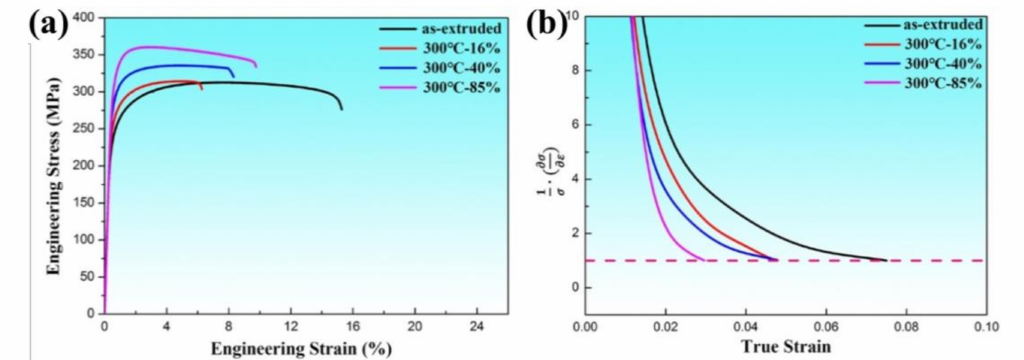
Figure 6. ( a ) Engineering tensile stress and strain curves of AlN / Al nanocomposites with various rolling reductions at 300 ◦ C; ( b ) the strain hardening rate curves of the four nanocomposites. Table 2. Tensile properties of AlN / Al nanocomposites after di ff erent rolling reductions at 300 ◦ C. Samples YS(MPa) UTS(MPa) Elongation (%) As-extruded